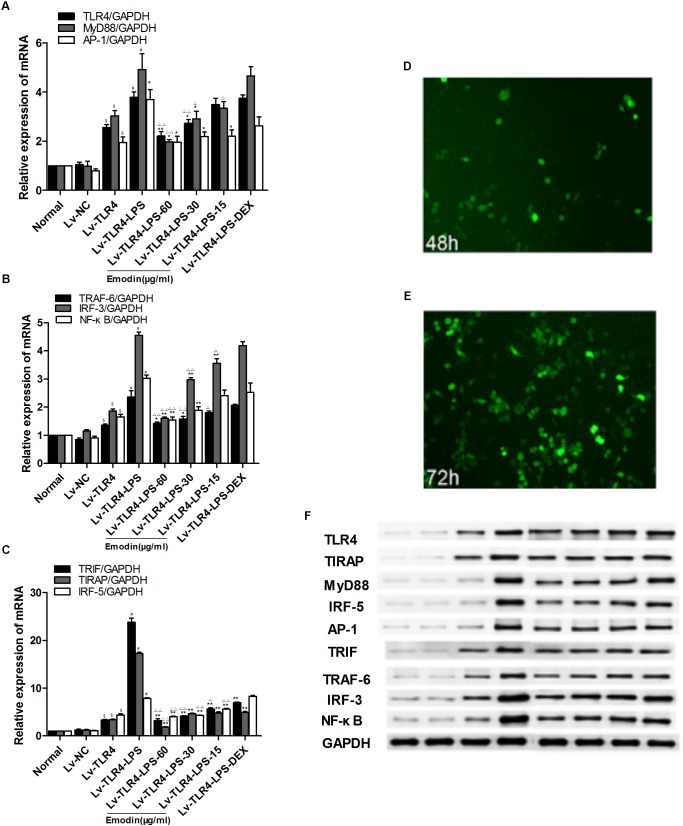
Effect of emodin on TLR4 and downstream molecules after TLR4 overexpression. Overexpression of TLR4 in Raw264.7 cells via the lentiviral vector. Lentivirus vector interferes with Raw264.7 cells for 72 h to mediate TLR4 overexpression. (A–C) The levels of TLR4 and downstream molecules MyD88, TIRAP, IRF-5, TRAF-6, TRIF, IRF-3, AP-1, and NF-κB after transfection were confirmed by real-time quantitative PCR. (D,E) The expression of TLR4 was observed with a fluorescence microscope after lentivirus was introduced into Raw264.7 cells for 48 and 72 h. (F) Expression of protein was assayed by western blotting. Data are shown as the mean ± SD. $P < 0.05 compared with the normal group; #P < 0.05 compared with the Lv-TLR4 group; ∗∗P < 0.05, ∗P < 0.01, compared with the Lv-TLR4-LPS group. ∆P < 0.05, ∆ ∆P < 0.01, compared with the DEX group. Lv-TLR4: TLR4 was overexpressed in Raw264.7 cells by lentivirus vector. Lv-NC: lentivirus vector negative control group.